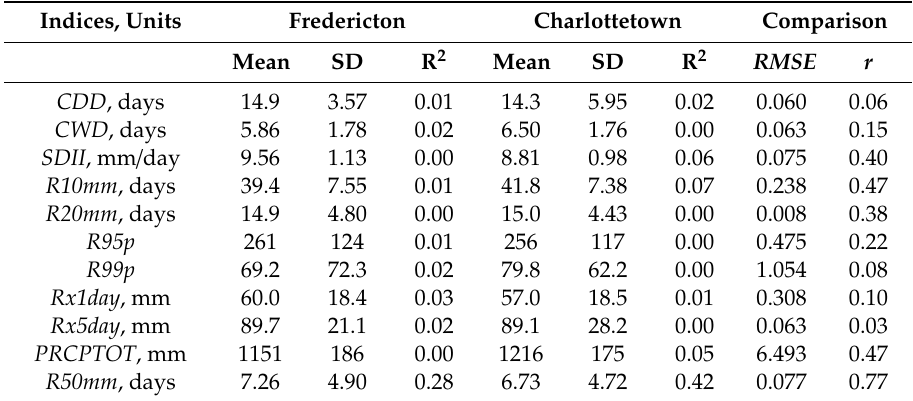
Table 5. Results of the descriptive statistics and regression applied individually on the city data to understand variations in the calculated indices within the city and on the combined data for similarities between the cities.